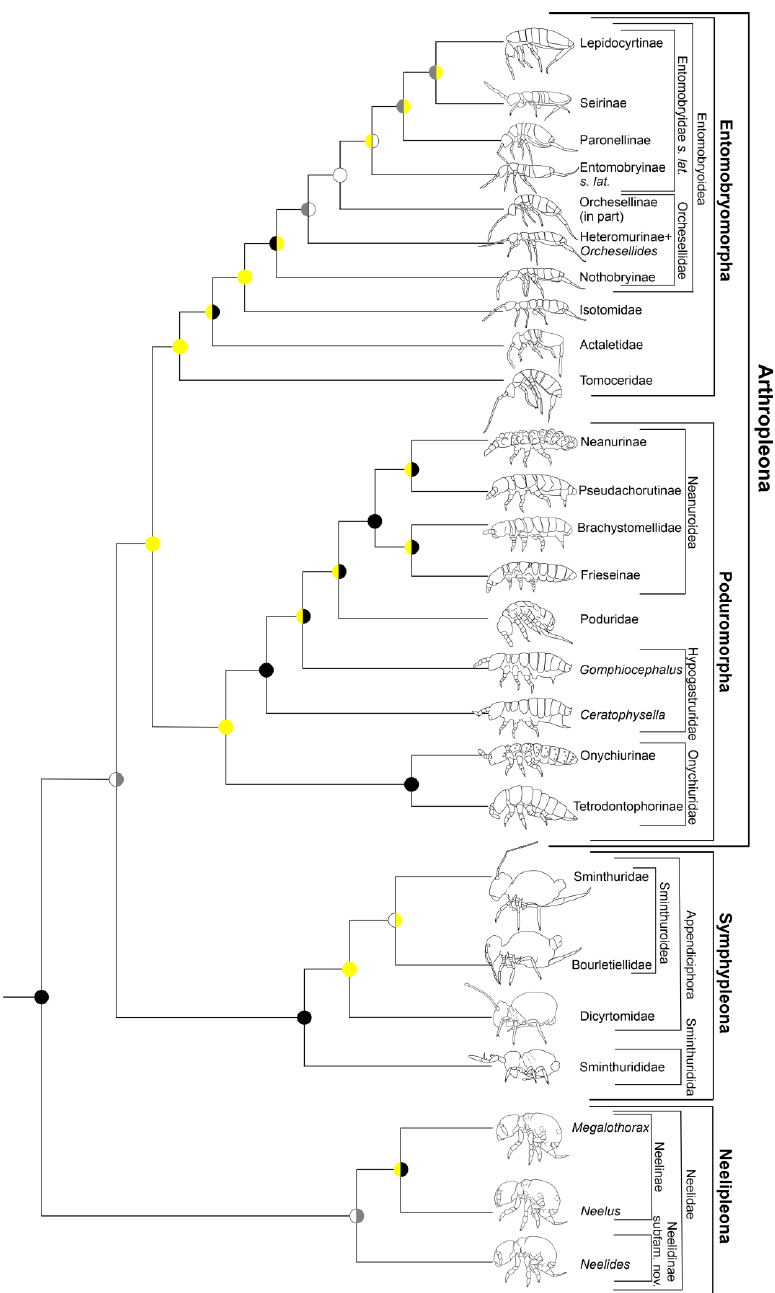
Figure 7. Summarized phylogenetic relationships of the sampled higher Collembola based on ML_1 tree. Node circles represent SH-aLRT support (left side) and bootstrap values (right side), respectively. Colors represent the following scores: black = 100; yellow = 95 – 99.9; grey = 90 – 94.9; white < 90.